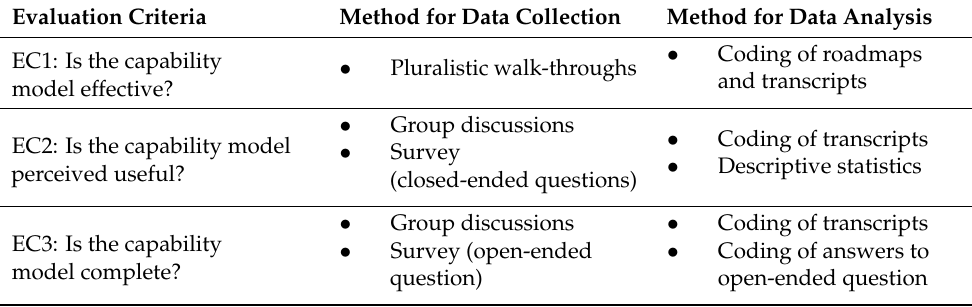
Table 1. Relation between the evaluation criteria, methods, and data